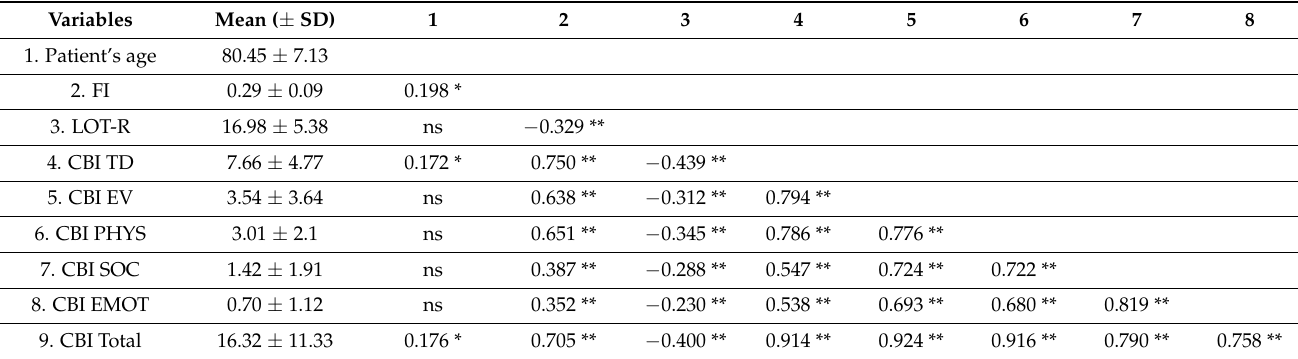
Table 2. Descriptive statistics and Pearson’s correlations between